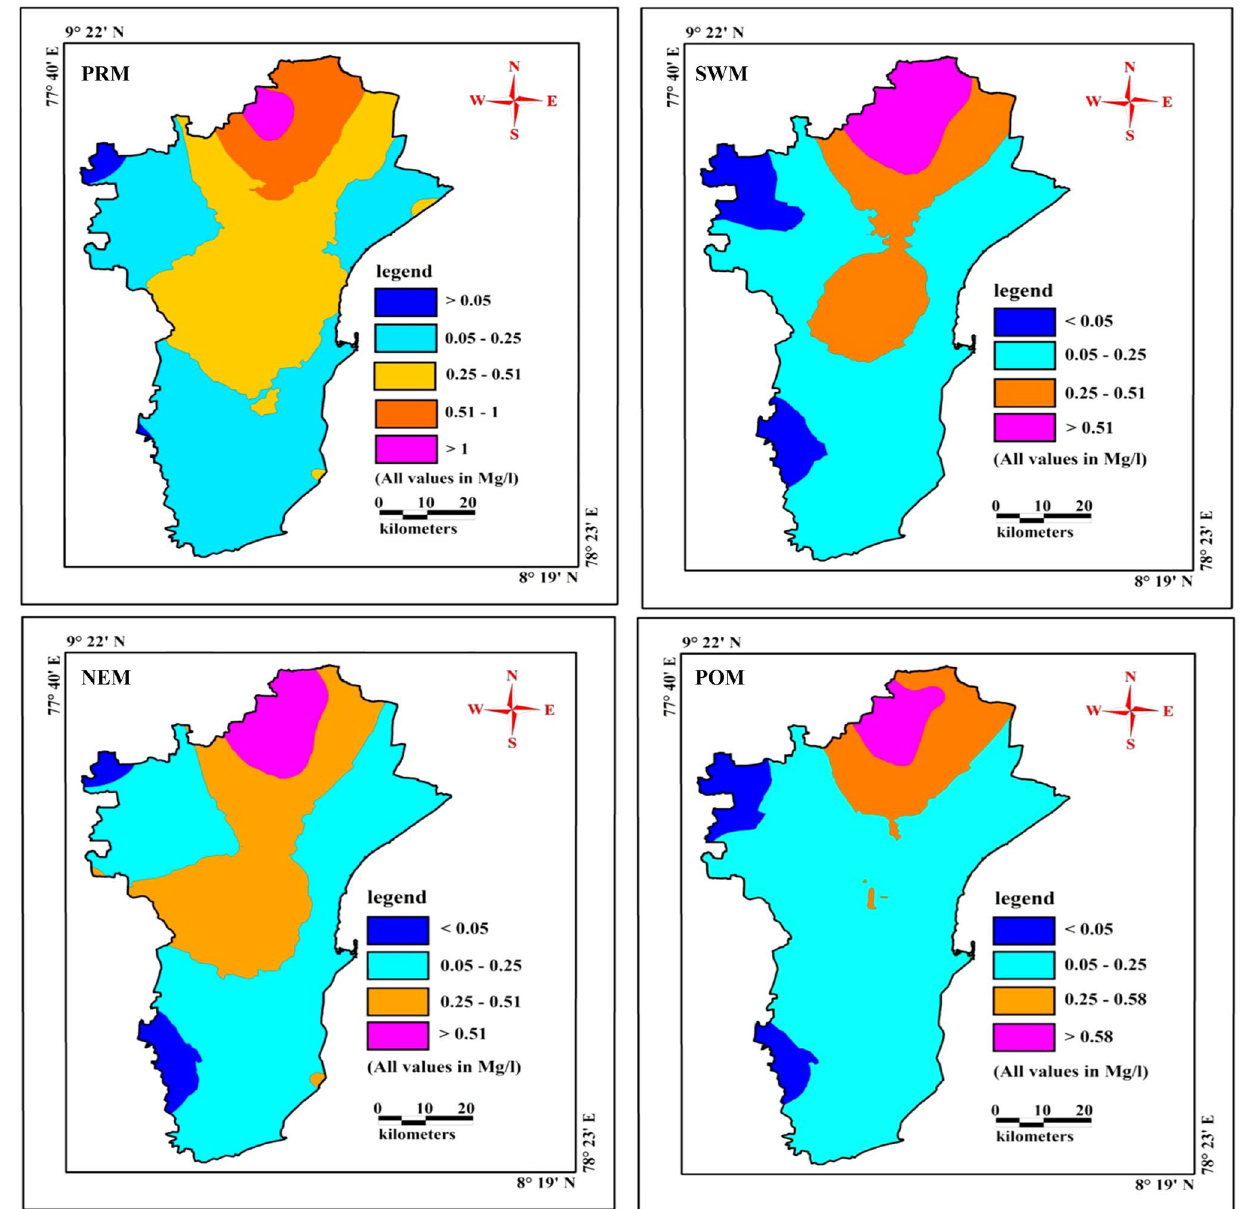
Fig. 10 Spatial distribution of F − during different